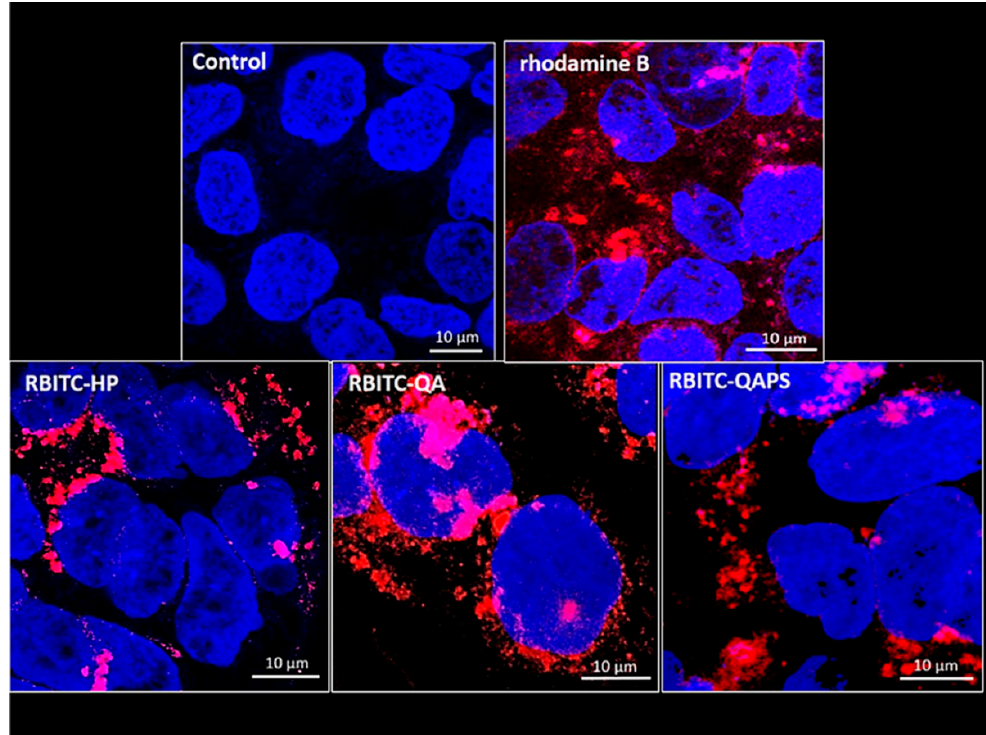
Figure 3. Uptake analysis of the fluorescence of RBITC-HP, RBITC-QA and RBITC-QAPS (5 µM) in CACO-2 cells by confocal microscopy after 30 min of exposure. The figure shows the internalization by CACO-2 cells of the different labelled beta-cyclodextrins in comparison with untreated cells or treated with rhodamine not conjugated (blue channel—nuclear stain; red channel—rhodamine alone or conjugated with beta-cyclodextrins).